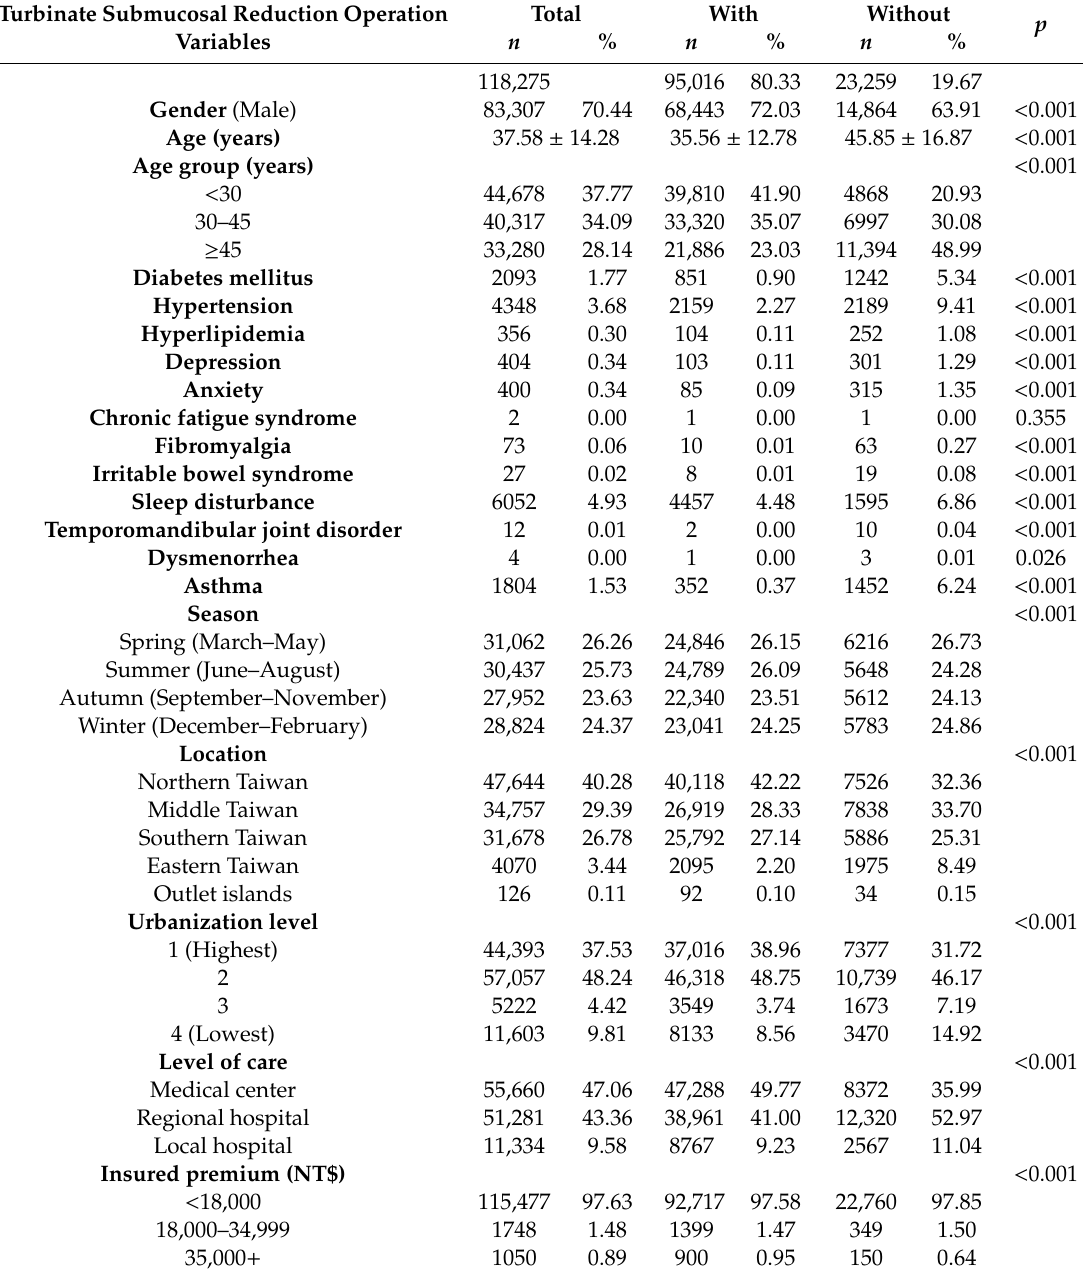
Table 1. Characteristics of the patients at